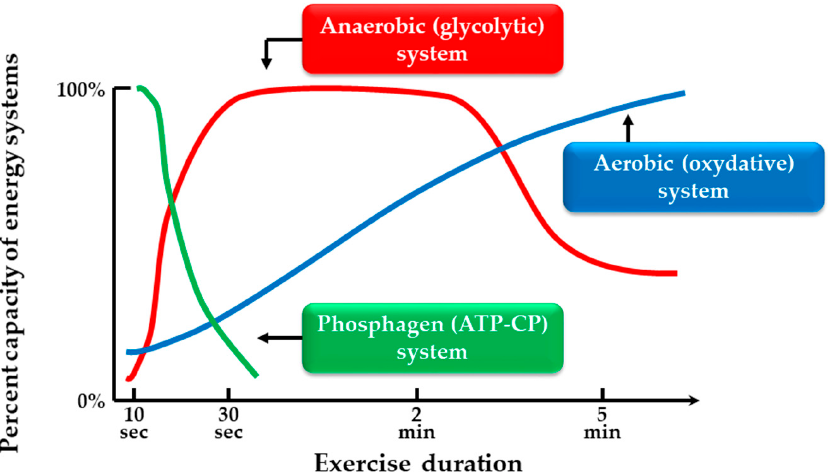
Figure 2. Three energy systems. Abbreviation: ATP-CP, adenosine triphosphate-creatine phosphate. The figure is adapted from Swanwick et al. [25] (CC BY NC 4.0). Table 1. Measurement of exercise intensity. Adapted from Vanhees et al.